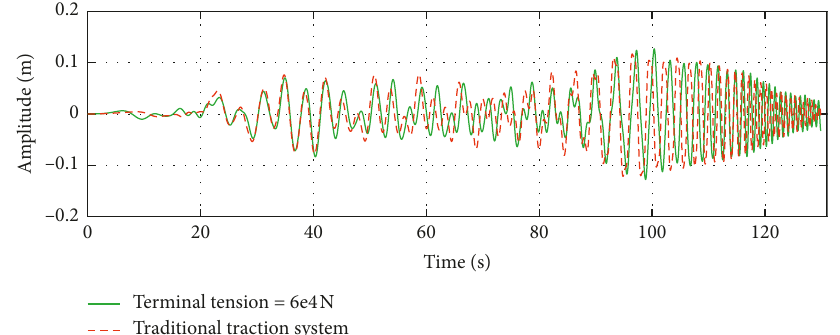
Figure 16: Comparison of transverse vibration displacements of the lifting ropes at the midpoint.